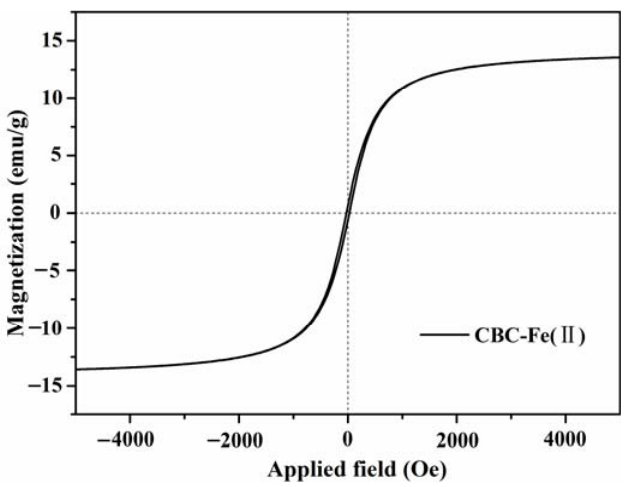
Figure 5. Magnetic hysteresis curves of CBC ‐ Fe(II).